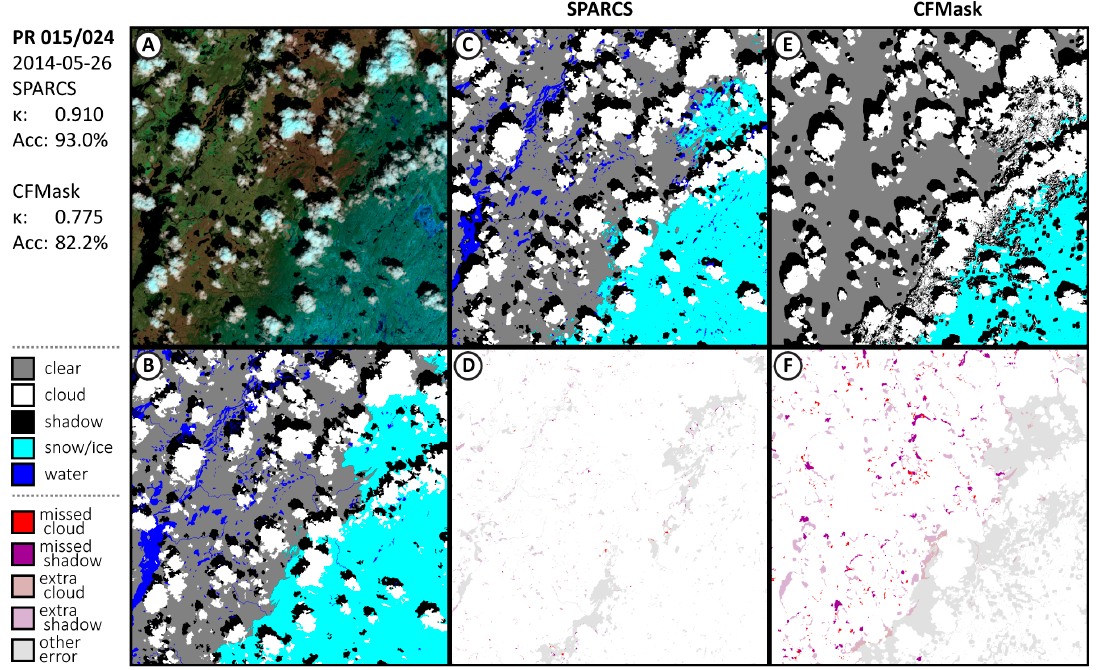
Figure A2. Results for validation test image PR 015/024, with false color image used during interpretation (A), the manually labeled interpretation (B), generated masks from SPARCS (C) and CFMask (E), and respective spatial distribution of errors (D, F).